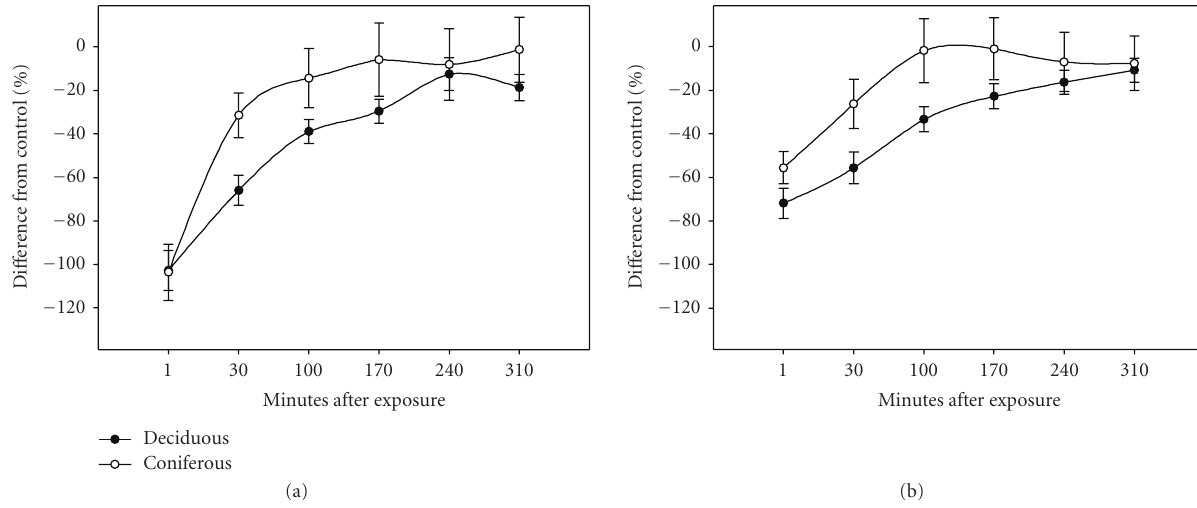
Figure 2: Decreased rates of photosynthesis expressed as percent di ff erence from control at both ambient (a) (385ppm) and saturating (b) (1000ppm) CO 2